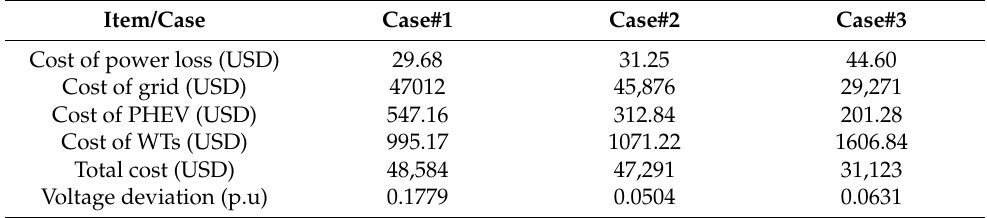
Table 4. Numerical results of PV and PHEV sizing and placement in the 33-bus distribution